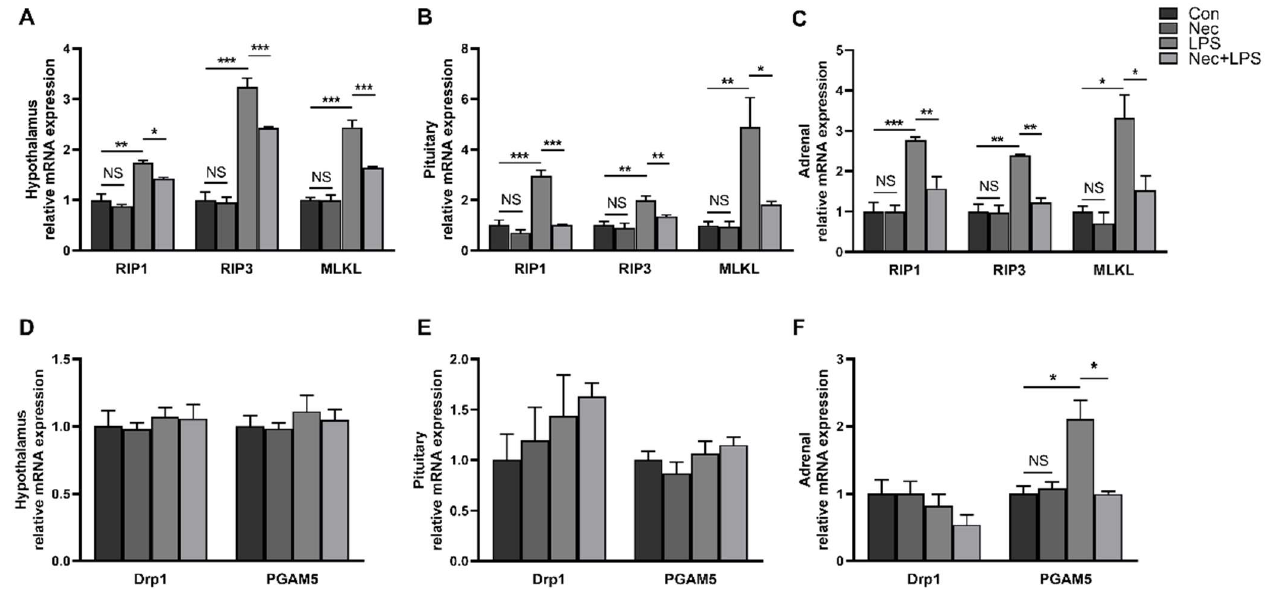
Figure 5. Nec-1 inhibits LPS-induced necroptosis of the hypothalamus, pituitary and adrenal gland. ( A ) mRNA expression of RIP1 , RIP3 , and MLKL in the hypothalamus. ( B ) mRNA expression of RIP1 , RIP3 , and MLKL in the pituitary gland. ( C ) mRNA expression of RIP1 , RIP3 , and MLKL in the adrenal gland. ( D ) mRNA expression of DRP1 and PGAM5 in the hypothalamus. ( E ) mRNA expression of DRP1 and PGAM5 in pituitary. ( F ) mRNA expression of DRP1 and PGAM5 in the adrenal gland. The pigs were pretreated intraperitoneally with Nec-1 at 1.0 mg/kg BW or equal volume of 2% DMSO solution 30 min before the intraperitoneal injection of LPS or saline, and the pigs were sacrificed at 4 h after LPS or saline injection. Values are means ± SEM, n = 7. NS means no significance, * p < 0.05, ** p < 0.01, and *** p < 0.001.